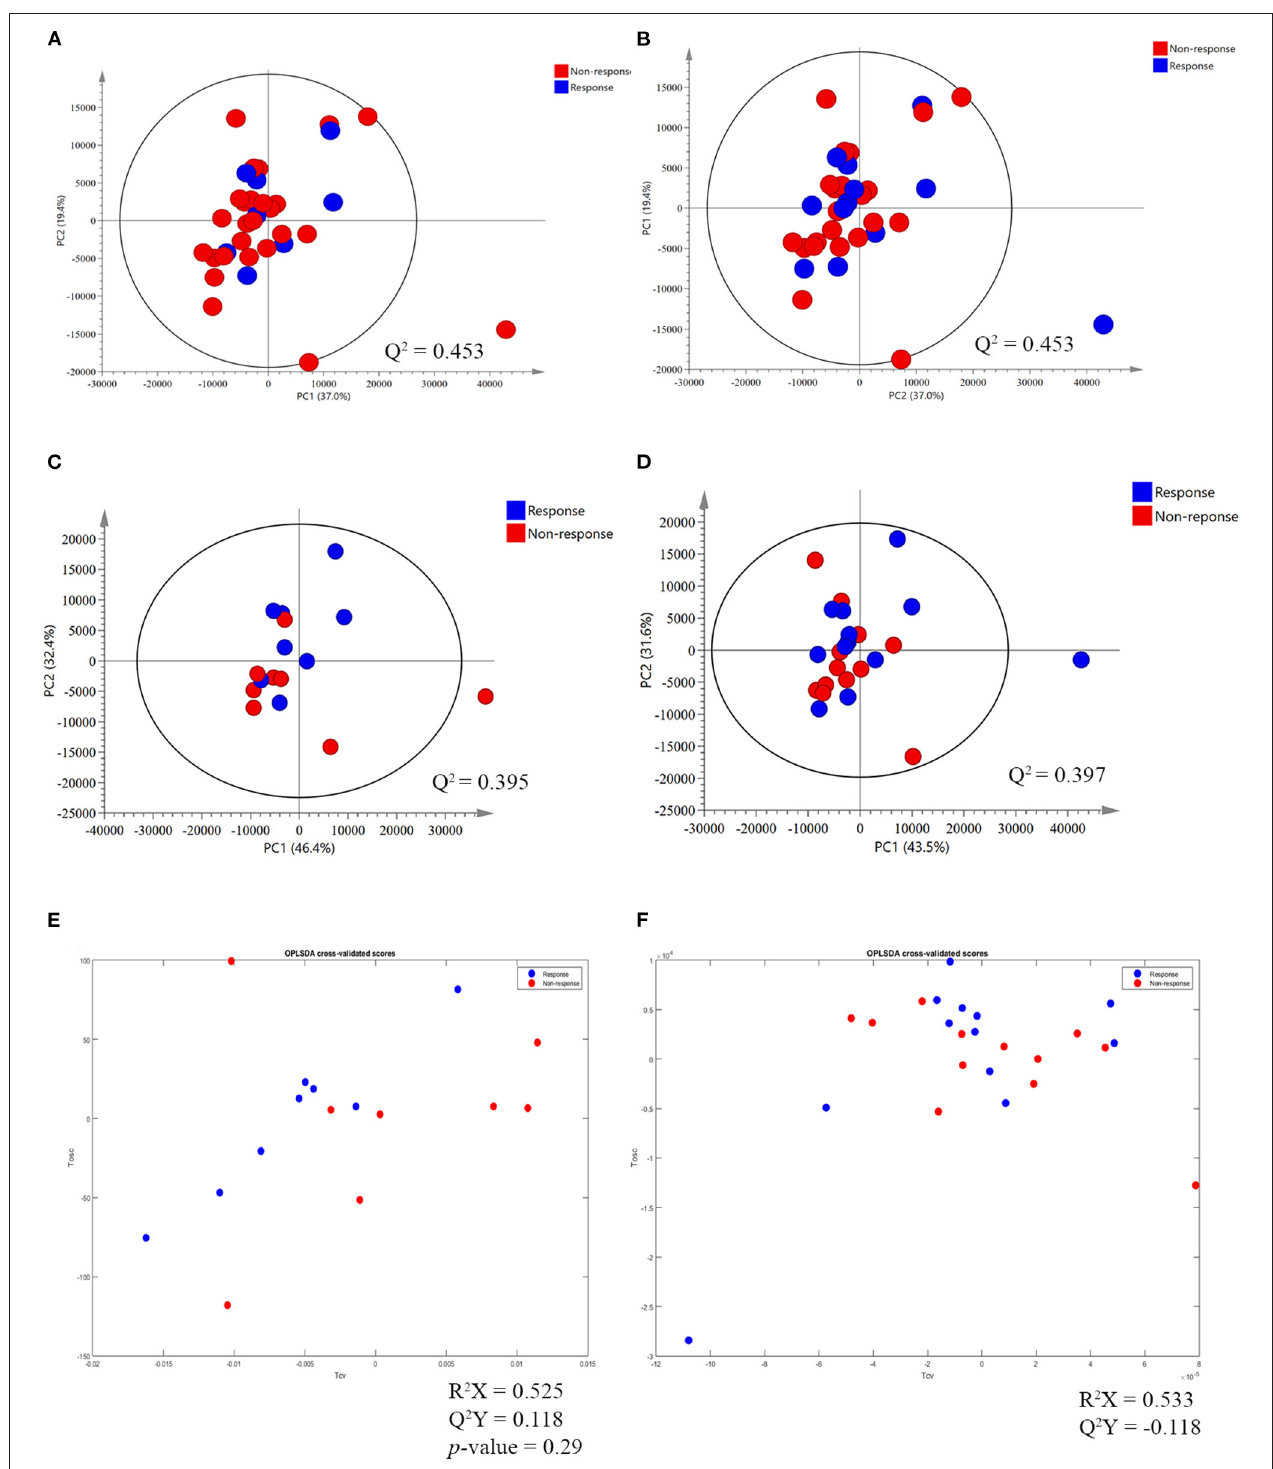
FIGURE 5 | The PCA and O-PLS-DA cross validated score plot between response and non-response patterns of gemcitabine and cisplatin in serum sample of patients with CCA. (A,B) The PCA score plot between the response and non-response group to gemcitabine and cisplatin, respectively, before matching the meta-data of patients with CCA. (C,D) The PCA score plot between the response and non-response group to gemcitabine and cisplatin, respectively, after matching the meta-data. (E,F) O-PLS-DA cross validated score plot between the response and non-response group to gemcitabine and cisplatin, respectively. The data were Pareto